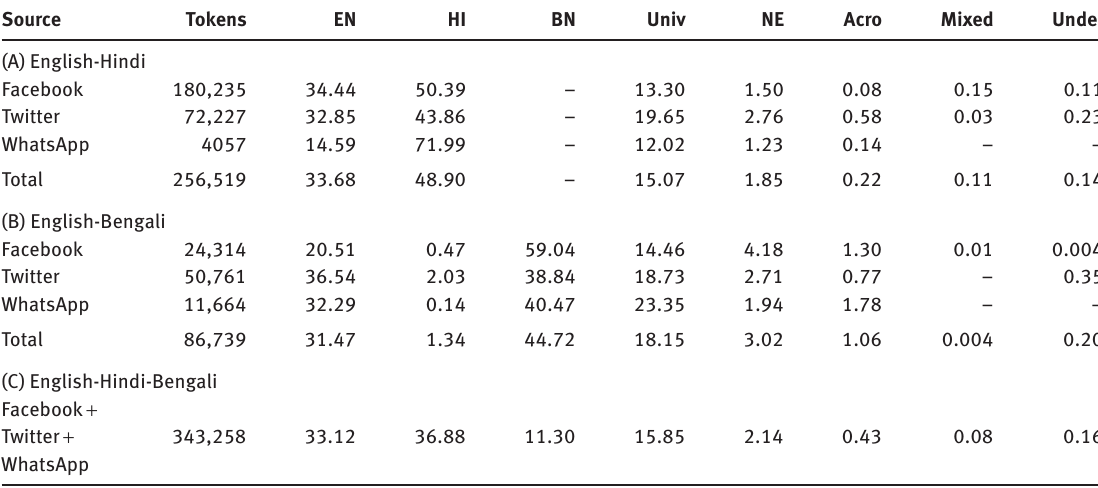
Table 1: Corpora Token-Level Language Distribution